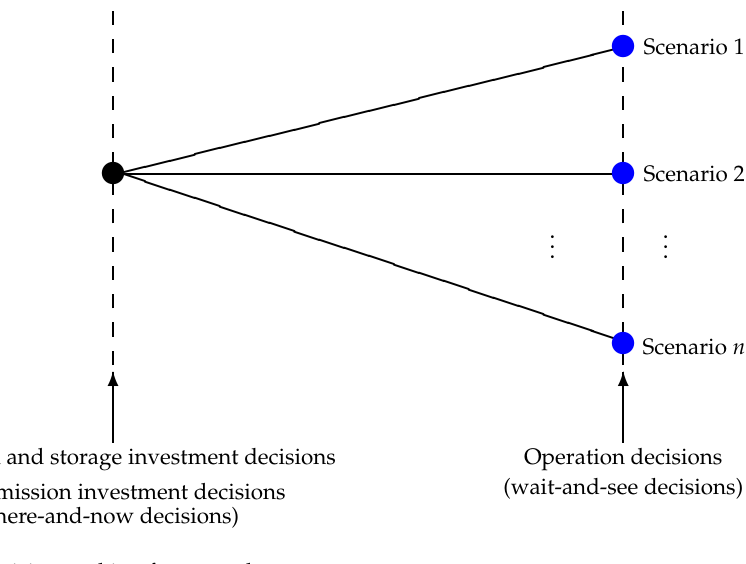
Figure 5. Decision-making